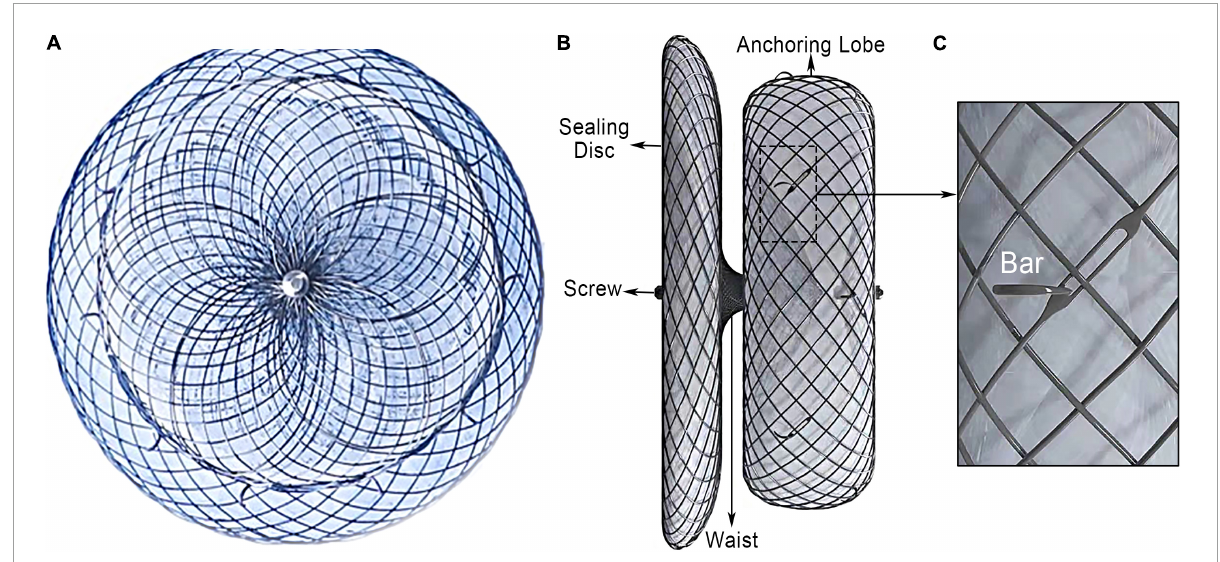
FIGURE1 LACbes R (cid:13) left atrial appendage device. (A) Side view of left atrial appendage; (B) lateral view of the occluder; (C) isogenous